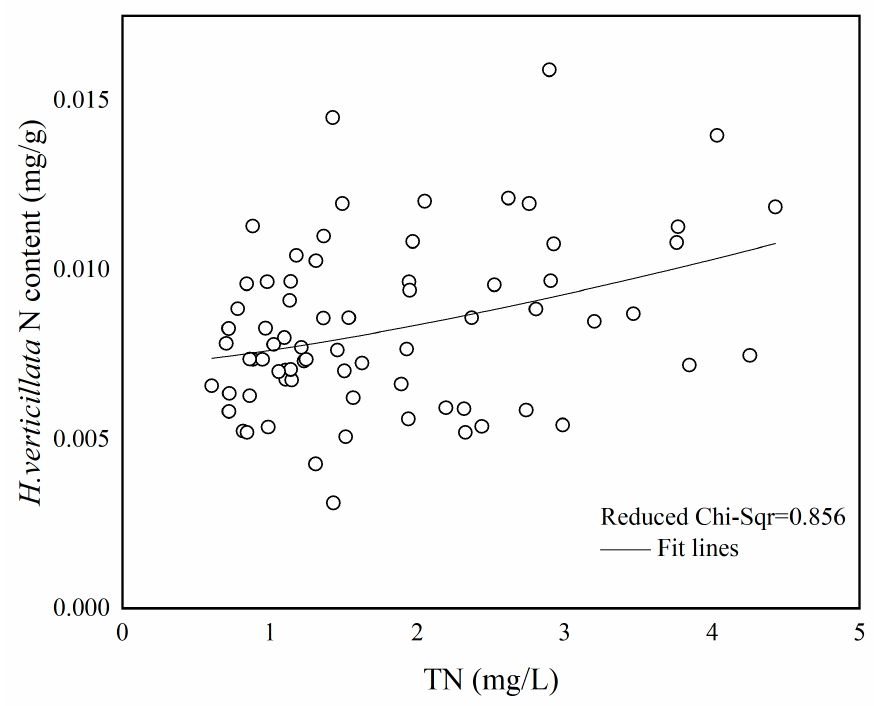
Figure 3. The relationship between H. verticillata N and water TN.